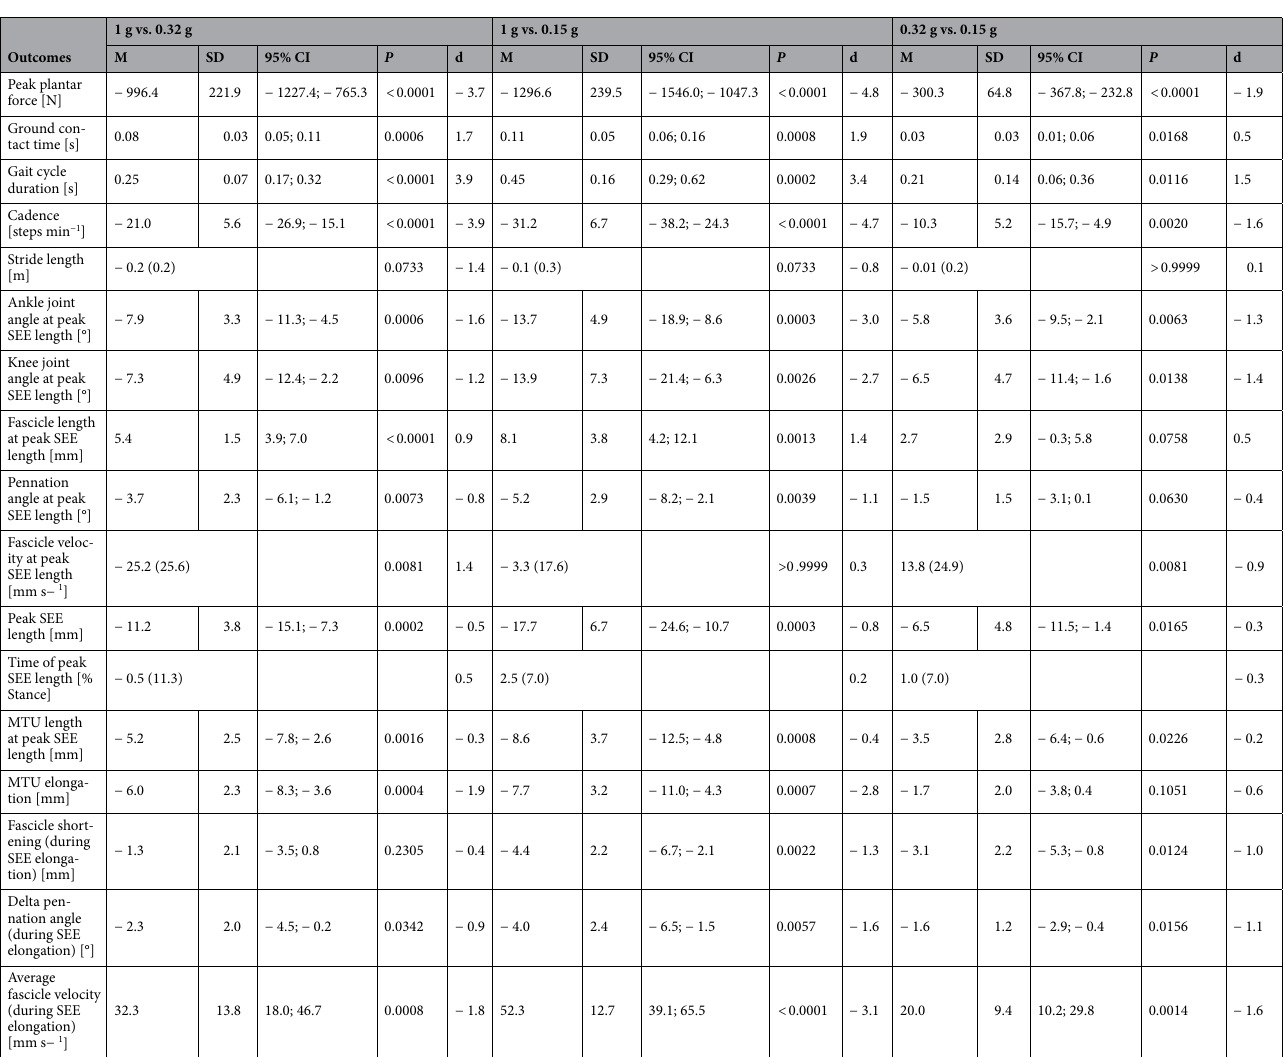
Table 2. Post-hoc results for kinetic, spatio-temporal, kinematic, gastrocnemius medialis fascicle and series elastic element parameters while participants ran at 125% PTS at 1 g and simulated Martian and Lunar gravity. PTS preferred walk-to-run transition speed; M mean; SD standard deviation; CI Confidence Interval; P result of the post-hoc test indicating a significant effect between conditions (α set to 0.05); d effect size (Cohen’s d) for the post-hoc test. Results of the Friedman test are presented as medians (interquartile ranges). Peak SEE length at 1 g and simulated 0.32 g (Mars), and 0.15 g (Moon) occurred at 52% ± 8%, 54% ± 4% and 53% ± 5% of stance, respectively. n =